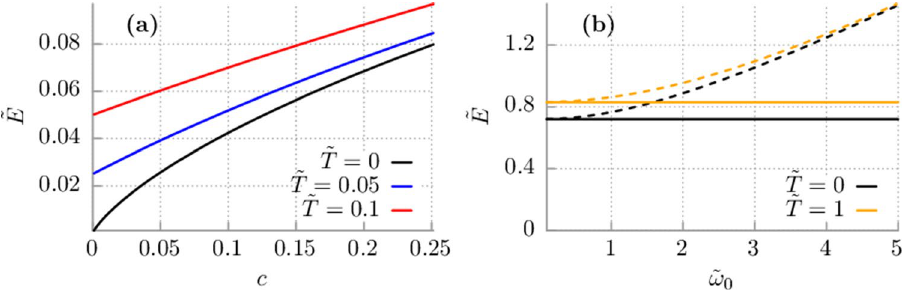
˜ E of the free quantum particle Figure 3. ( a ) Impact of temperature on the dimensionless mean kinetic energy within the Drude model. ( b ) Influence of the eigenfrequency ˜ ω 0 of the harmonic oscillator on its mean ˜ E . Solid lines represent the results for the free particle where the dashed ones correspond to the kinetic energy ˜ ˜ E = E / (cid:31) ω c , temperature T = k B T / (cid:31) ω c and ˜ ω = ω/ω c . In ( b ) harmonic oscillator. The dimensionless energy c = 10